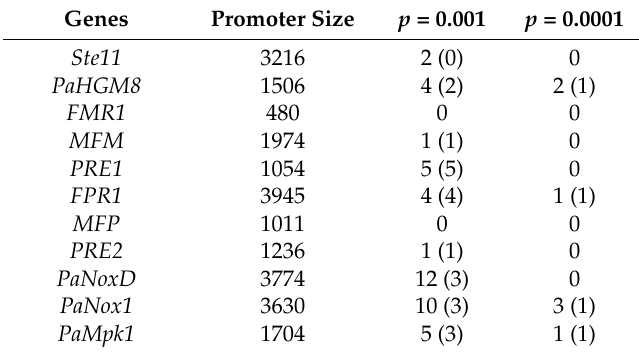
Table 1. Pro1 motifs found using FIMO analysis in the promoters of selected genes. Genes Promoter Size p = 0.001 p = 0.0001 Ste11